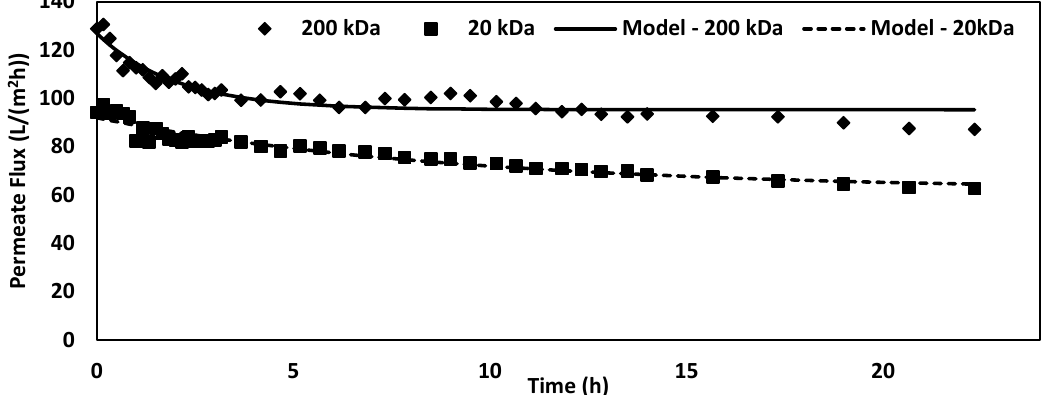
Figure 8. Exponential fouling model on 200 kDa and 20 kDa in membrane filtration experiment at 6.89 bar.